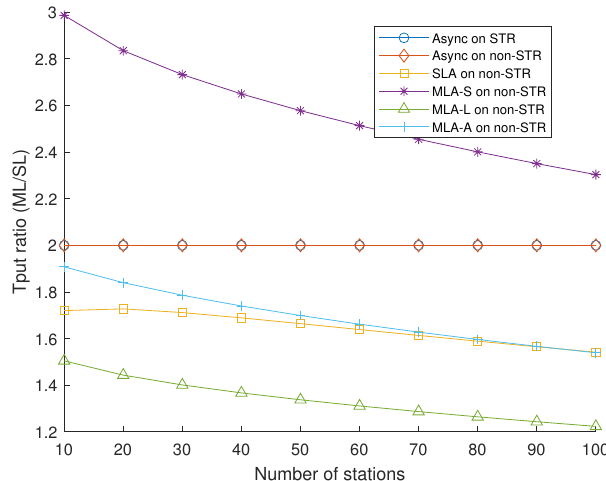
Figure 12. Throughput ratio between MLDs and single-link